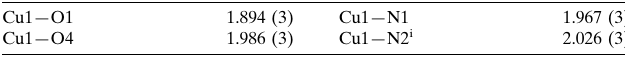
centrosymmetric dinuclear complex,